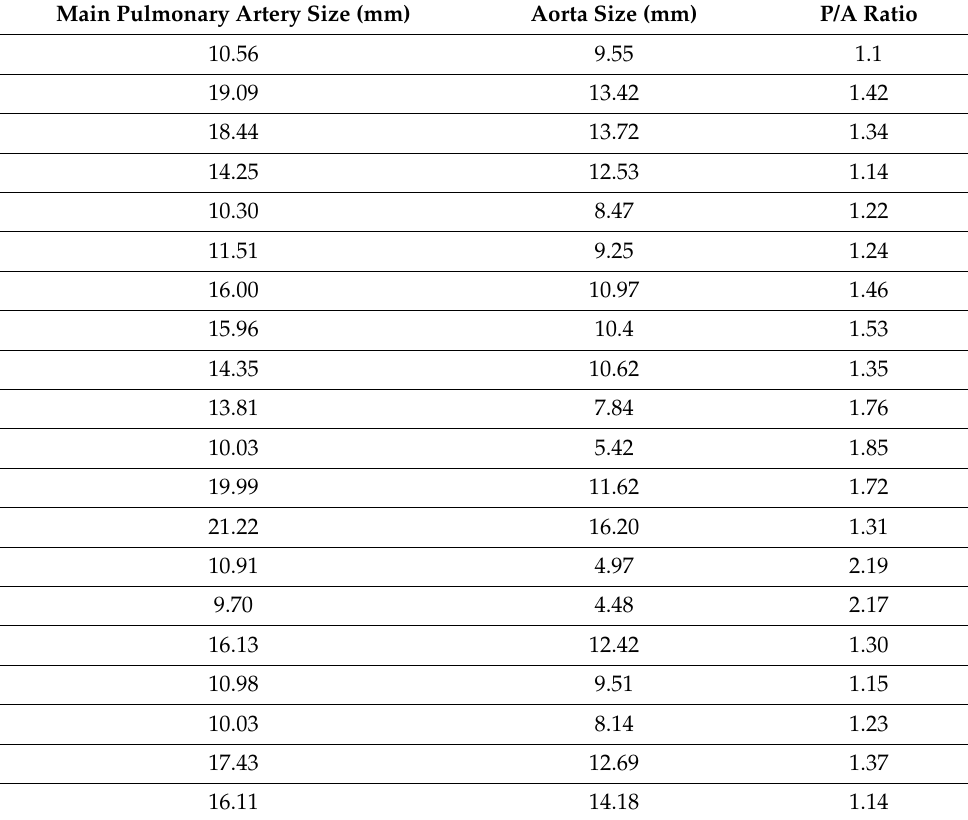
Table 2. Main Pulmonary Artery (Pulmonary Trunk) to Ascending Aorta